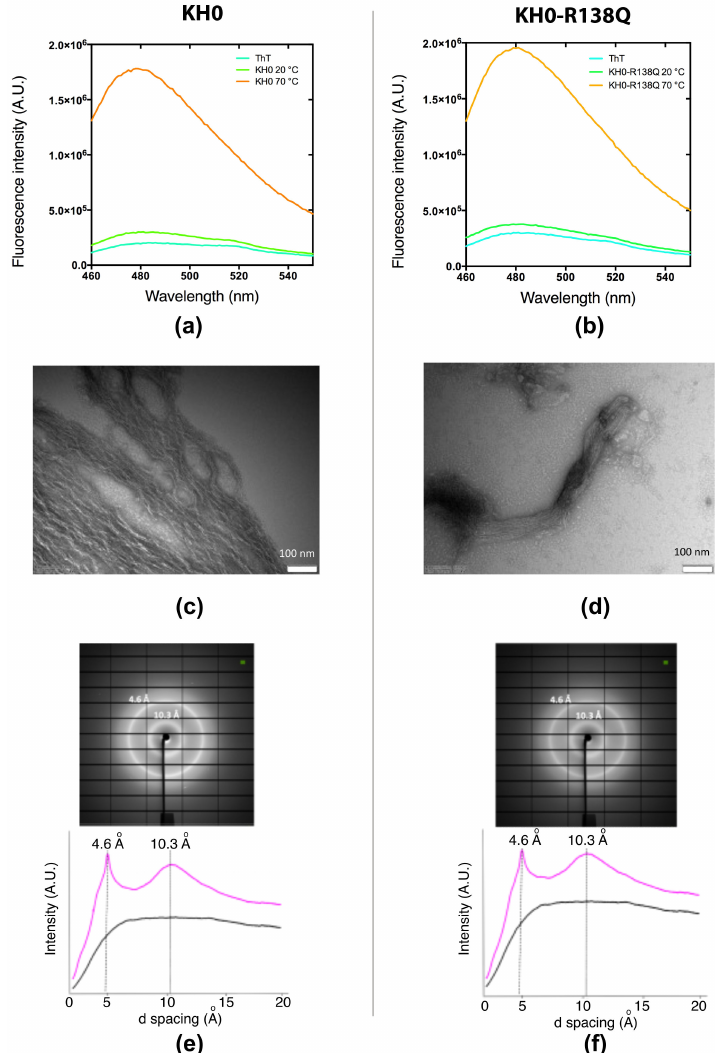
Figure 4. Fluorescence spectra recorded after adding a stoichiometric amount of ThT in pre-incubated samples at 70 ◦ C and 20 ◦ C of 20 µ M KH0 ( a ) and KH0-R138Q ( b ) in 20 mM sodium phosphate pH 7.2 100 mM NaCl. TEM analysis. Transmission electron micrograph of heat-induced fibrils after 2 h incubation at 55 ◦ C of 50 µ M KH0 ( c ) and 50 µ M KH0-R138Q ( d ) The scale bars correspond to 100 nm in both panels. X-ray analysis. X-ray diffraction analysis of KH0 ( e ) and KH0-R138Q ( f ); samples (100 µ M) were heated at 37 ◦ C for 50